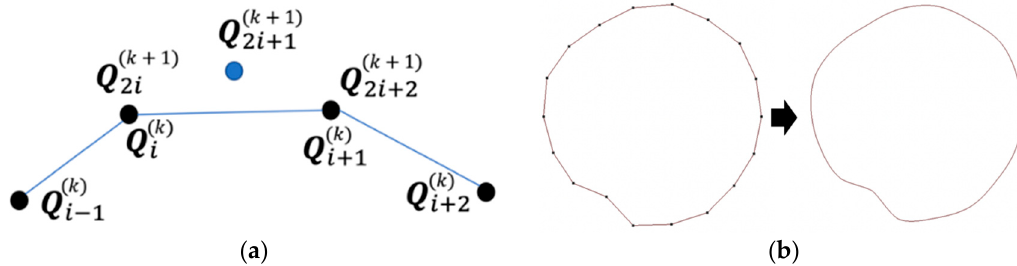
Figure 13. Stem representation using spline curve. ( a ) Four-point subdivision scheme; ( b ) interpolation by subdivision scheme.